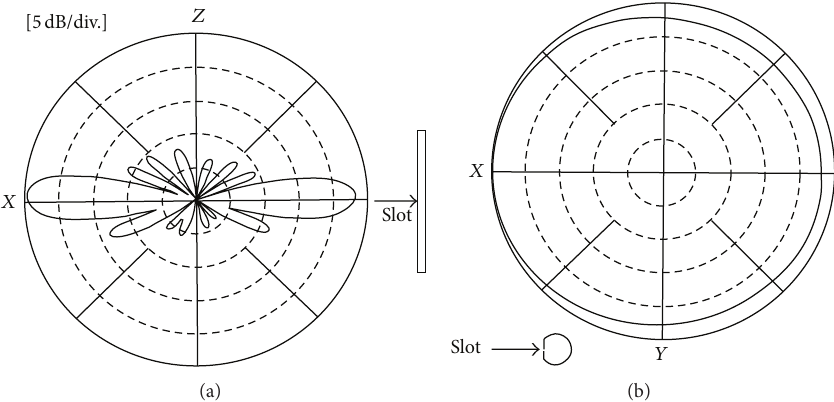
Figure 8: Measured radiation patterns of the four-element DSCA array (H antennas). (a) Vertical plane. (b) Horizontal plane.